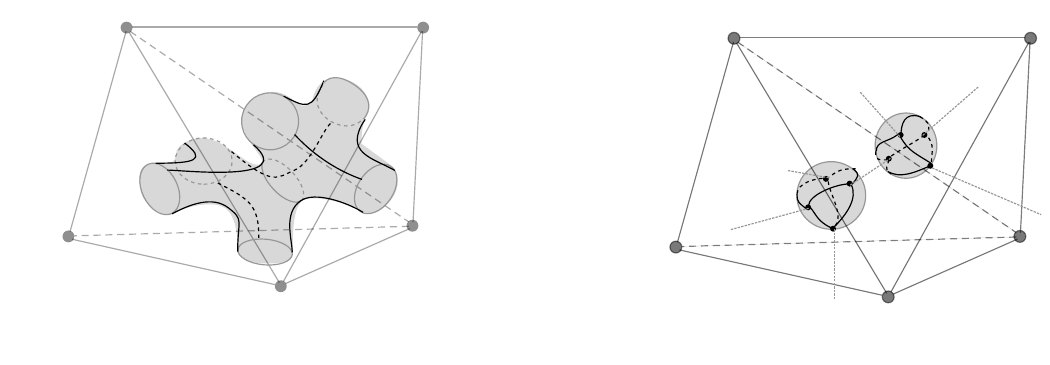
Figure 28 . The third step of a swiss cheese construction. The complement of the holes is a collec- tion of solid cylinders running through faces of the triangulation, fused at tetra-valent vertices inside the tetrahedra. The cross-section of the solid cylinders is a disk with three boundary punctures. We insert a complete basis of states along each cylinder.